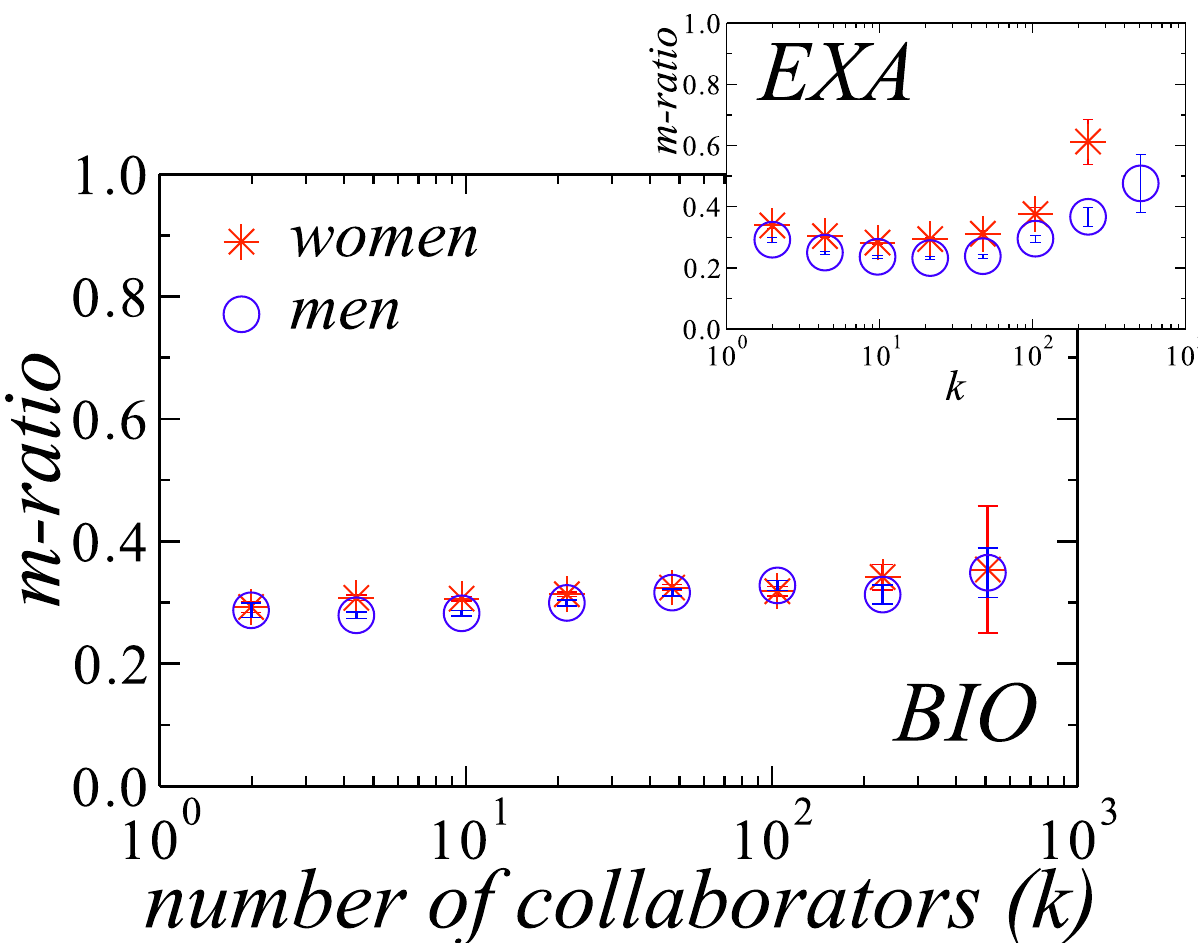
Fig 4. Dependence of the m-ratio on the number of collaborators in Biological Sciences (BIO, main plot) and Exact and Earth Sciences (EXA, inset) for women (red starts) and men (blue circles). Except for Exact and Earth Sciences (see inset), there is only a slight difference regardingmultidisciplinarycollaborations. Error bars indicatethe standarderror for each bin.